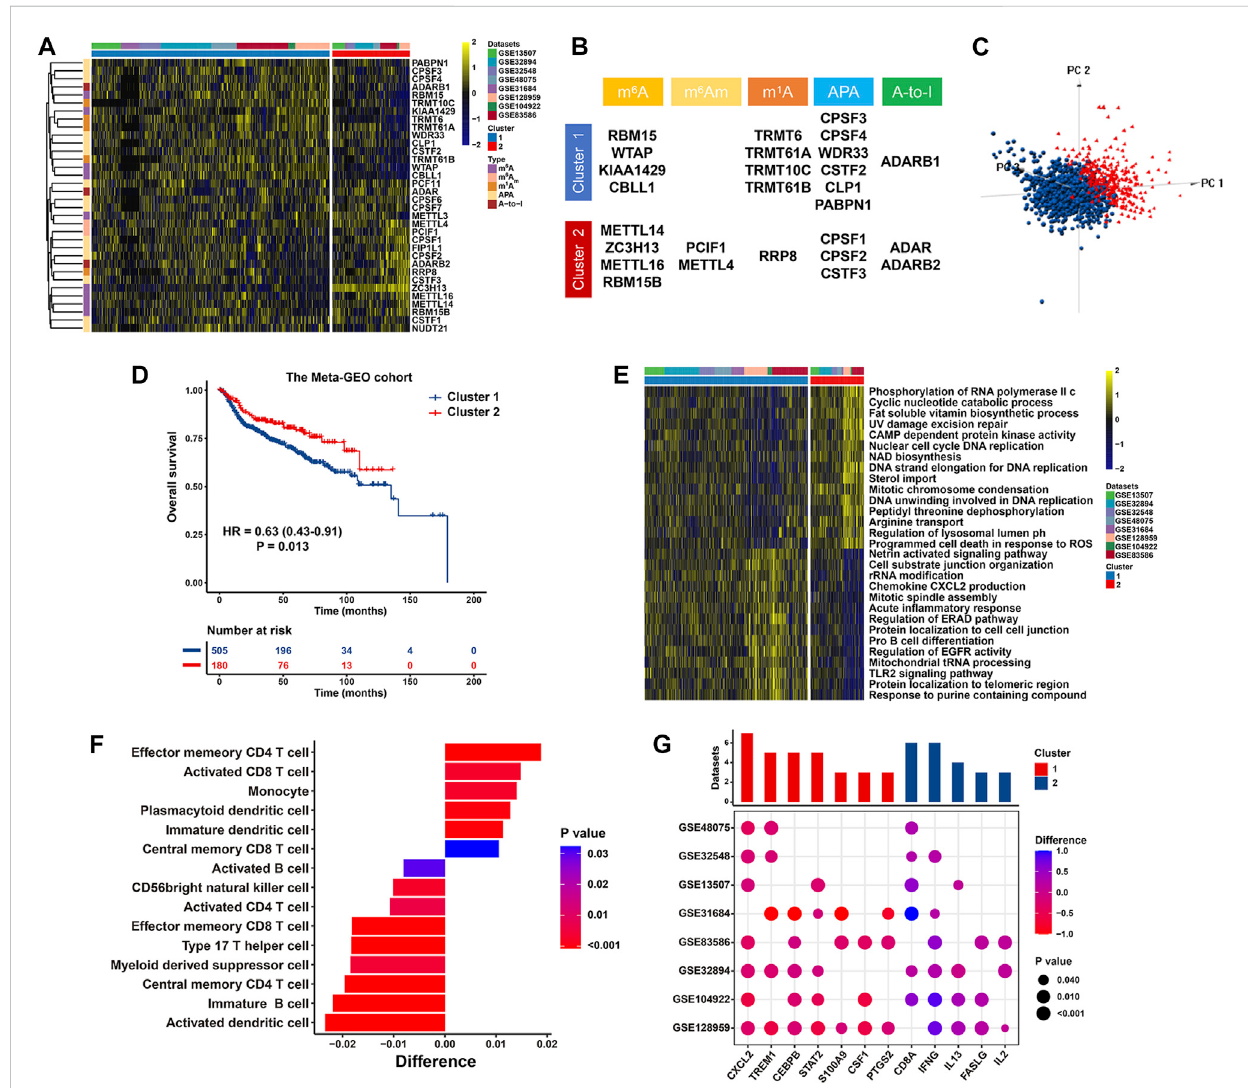
FIGURE 5 RNA modi fi cation patterns and their biological signi fi cance in the meta-GEO cohort. (A) Heatmap presenting unsupervised clustering results of 34RNAmodi fi cation “ writers ” ineightindependentBCacohorts.EachcolumnandrowrepresentedpatientsandRNAmodi fi cation “ writers ” ,respectively. (B) Speci fi c distribution of 34 RNA modi fi cation “ writers ” enriched in two primary patterns. (C) PCA illustrating the expression of 34 RNA modi fi cation “ writers ” to distinguish two primary patterns in 1,410 BCa patients. (D) Kaplan-Meier curve of patients ’ OS in two RNA modi fi cation patterns. (E) Heatmap displaying the difference in relatively activated biological processes between two distinct RNA modi fi cation patterns by GSVA. (F) Bar chart showing the proportion of immune cells between two clusters. Difference > 0 or < 0 represented the immune cells enriched in Cluster 2 or Cluster 1, respectively. (G) Difference in the expression of MDSCs and activated CD8 + T cells marker genes between two clusters. The upper bar chart represented thenumber ofdatasets that weresigni fi cantly differentbetweenCluster1 and Cluster2. The color andsize bubble illustratedthedifference ineach GEO, and the statistical signi fi cance of difference, respectively. Difference > 0 or < 0 implied greater expression of immune cell marker genes in Cluster 2 or Cluster 1,